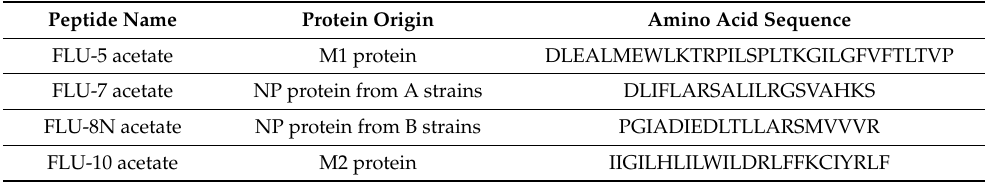
Table 1. Amino acid sequences of the peptides included in the FLU-v vaccine and the protein antigens they originate